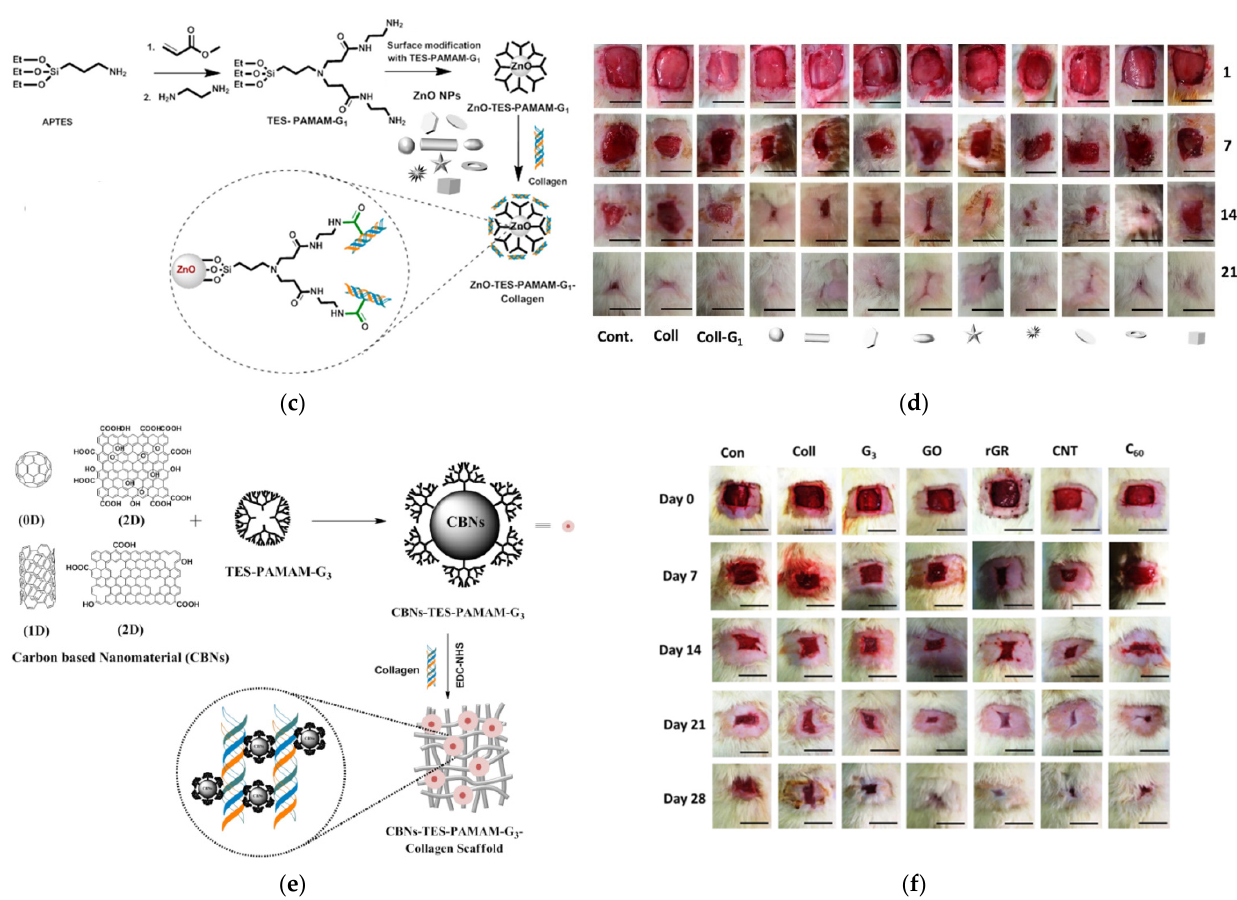
Figure 33. ( a ) Schematic diagram of the construction of collagen scaffolds ( b ) Representative photo- graphs of excisional wounds on Wistar albino rats at different time intervals following treatment with ZnO, TiO 2 , Fe 3 O 4 , CeO 2 , and SiO 2 . Scale bar: 5 mm. Both are published with permission from [280]. Copyright: Springer Nature. ( c ) Schematic diagram depicting the method of combining different shaped ZnO-TES-PAMAM-G1 Nps with collagen scaffold. ( d ) The wound healing capacity of collagen, collagen-TES-PAMAM-G1, and variable morphology of ZnO nanoparticle cross-linked collagen scaffold on Wistar Albino rats at days 1, 7, 14, and 21. Both are published with permission from [281]. Copyright: American Chemical Society. ( e ) Schematic representation of the production of cross-linked collagen scaffold with G3 PAMAM functionalized carbon nanomaterials. ( f ) Repre- sentative photographs of full-thickness excision wound healing process. Both are published with permission from [282]. Copyright: Elsevier Ltd. Table 6. Dendritic polymers for healing wounds on the skin. Dendritic